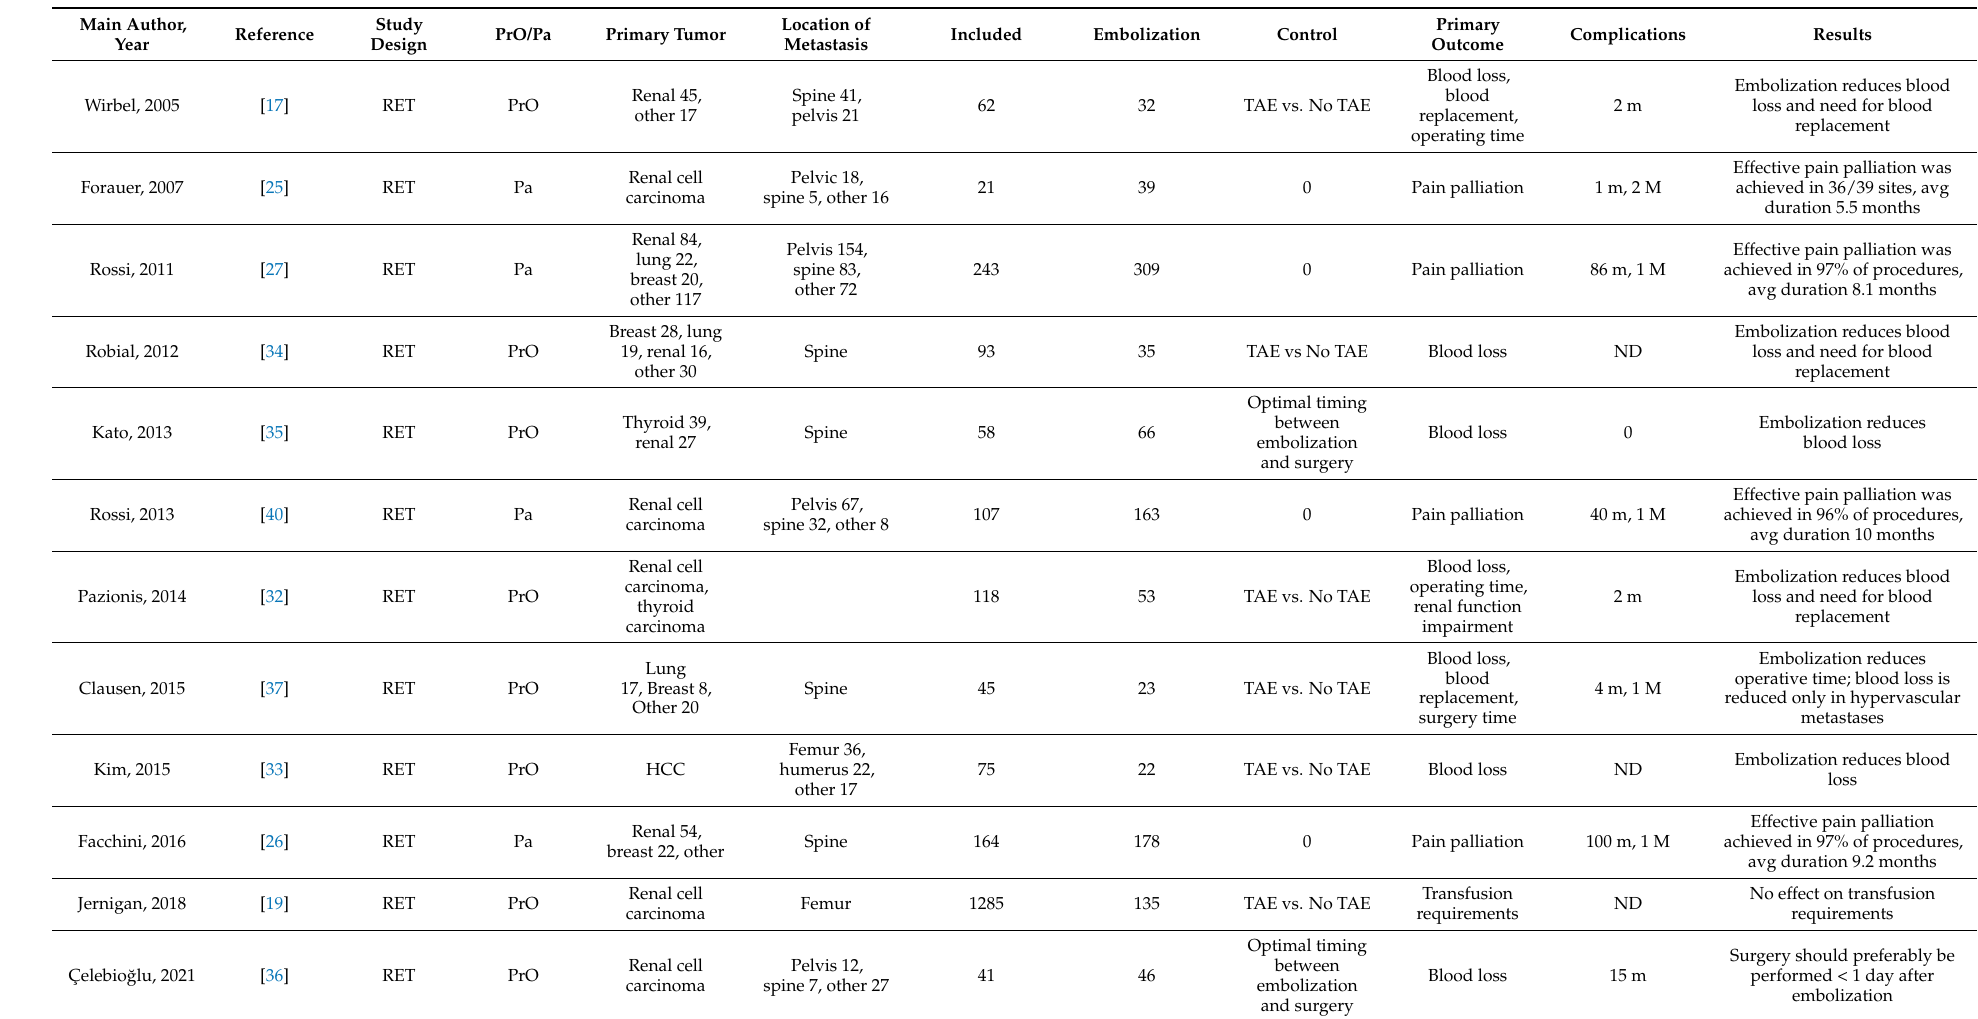
Table 1. Studies evaluating the role of transarterial embolization (TAE) in the management of bone